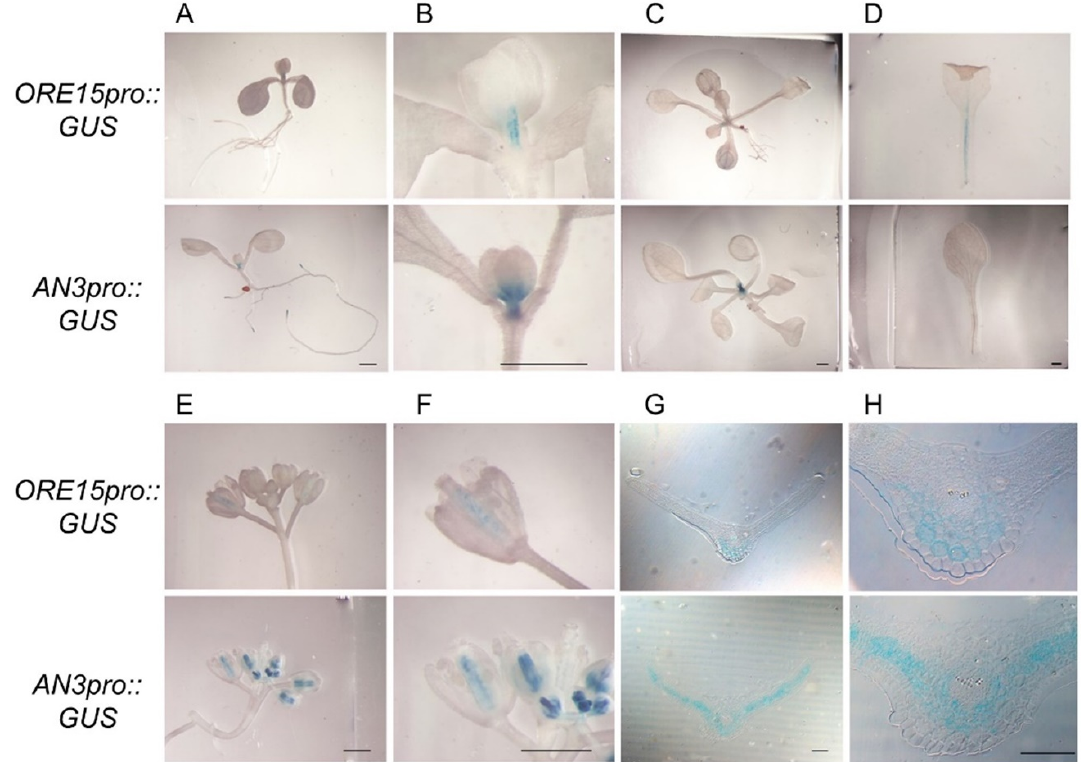
Figure 1. Spatial and temporal specific expression of ORE15 and AN3 determined by promoter:: β -glucuronidase (GUS) assay of transgenic plants harboring the ORE15 promoter:: GUS and AN3 promoter:: GUS construct. ( A ) Seedling with the first pair of true leaves at seven days after sowing (DAS). ( B ) Magnified view of (A). ( C ) Seedling at 14 DAS. ( D ) First true leaf pair in the juvenile phase at 14 DAS. ( E ) Young floral bud. ( F ) Mature flower. Scale bar = 10 mm. ( G ) Transverse section of the proximal part of leaf blades from GUS-stained third leaf at 14 DAS. ( H ) Magnified view of (G). Scale bar = 100 µ